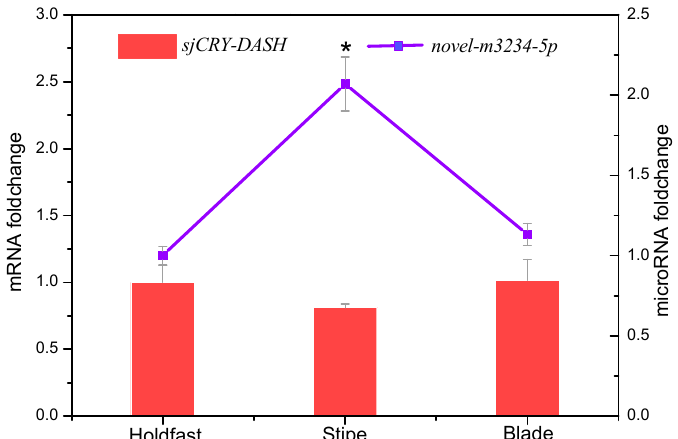
Figure 6. Identification of sjCRY-DASH as a target gene of novel-m3234 in S. japonica . ( A ) Base-pairing interaction between novel-m3234-5p and sjCRY-DASH . ( B ) Secondary structure of the predator sequence of novel-m3234-5p . ( C ) qRT-PCR analysis of miRNA and lncRNA expression that targeted sjCRY-DASH genes. Non-coding RNA expression levels in the dark were used for data normalization. Each value was performed in six biological samples. The data in the figures represent the averages ± standard deviation. One-way ANOVA was used for statistical comparisons between groups. * p < 0.05, and ns = not significant.